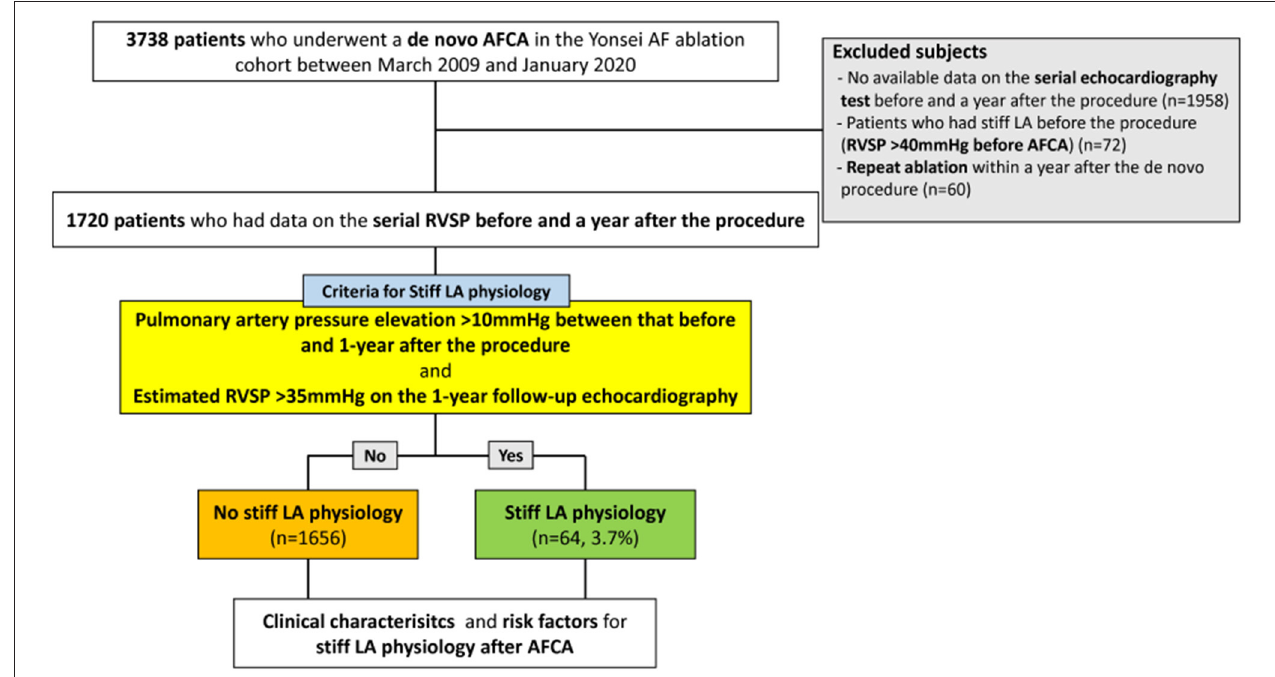
FIGURE 2 | Flow chart of the study. AFCA, atrial fibrillation catheter ablation; LA, left atrial or left atrium; RVSP, right ventricular systolic